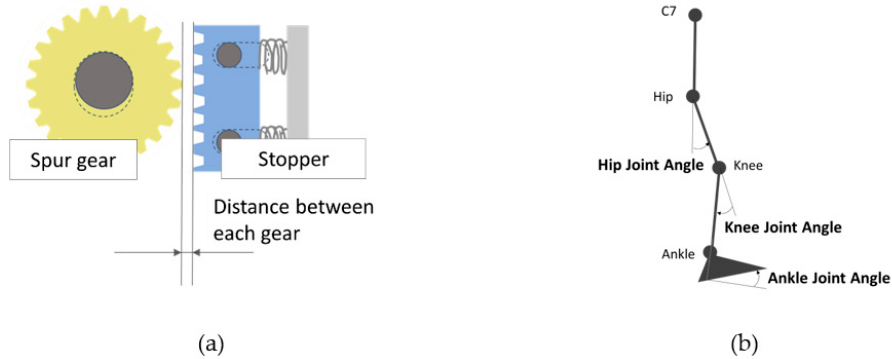
Figure 6. Definition of the kinematics data. ( a ) Distance between each tip of the gear and stopper. ( b ) Joint angles of the hip, knee, and ankle.